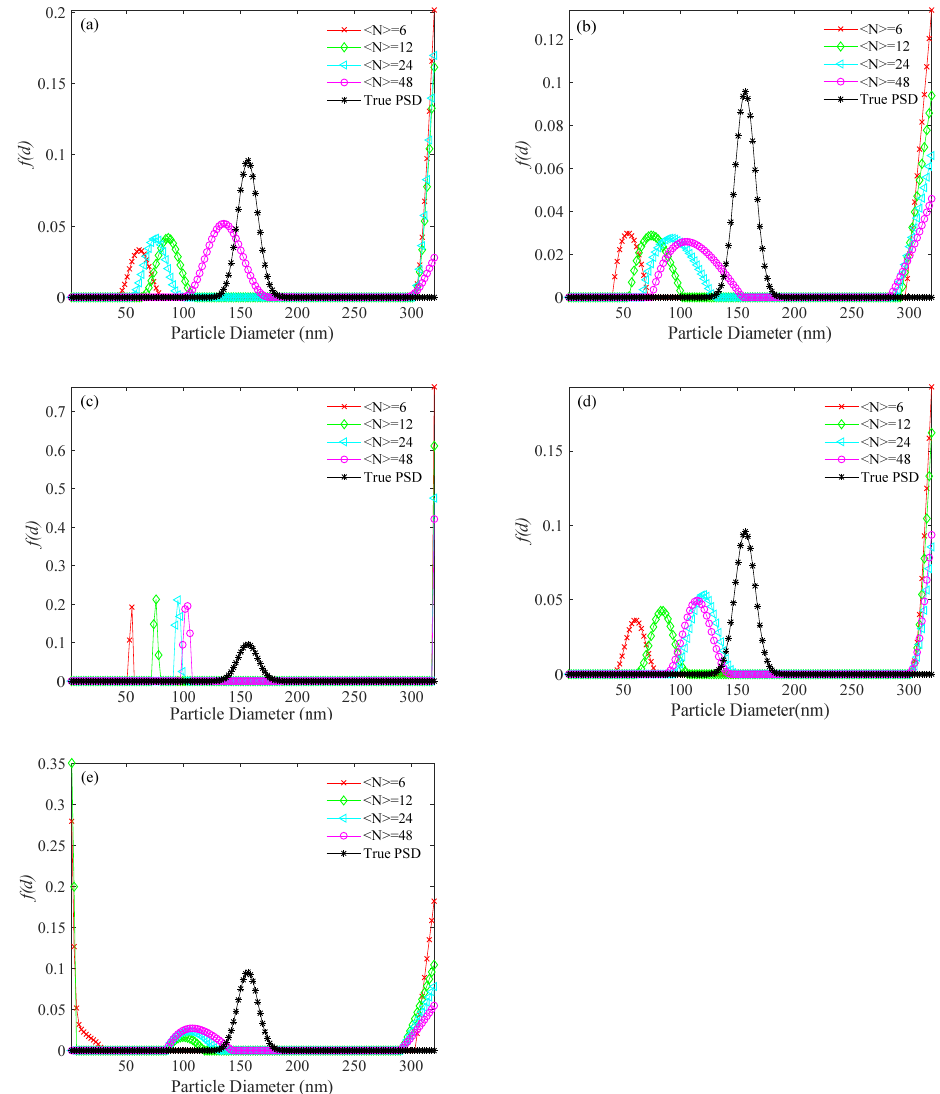
Figure 4. PSD recovered by the usual method for a 156 nm unimodal sample at number concentrations of < N > = 6, 12, 24, 48, and different levels of noise. ( a ) 0, ( b ) 10 − 4 , ( c ) 10 − 3 , ( d ) 10 − 2 , and ( e ) 10 − 1 noise levels.